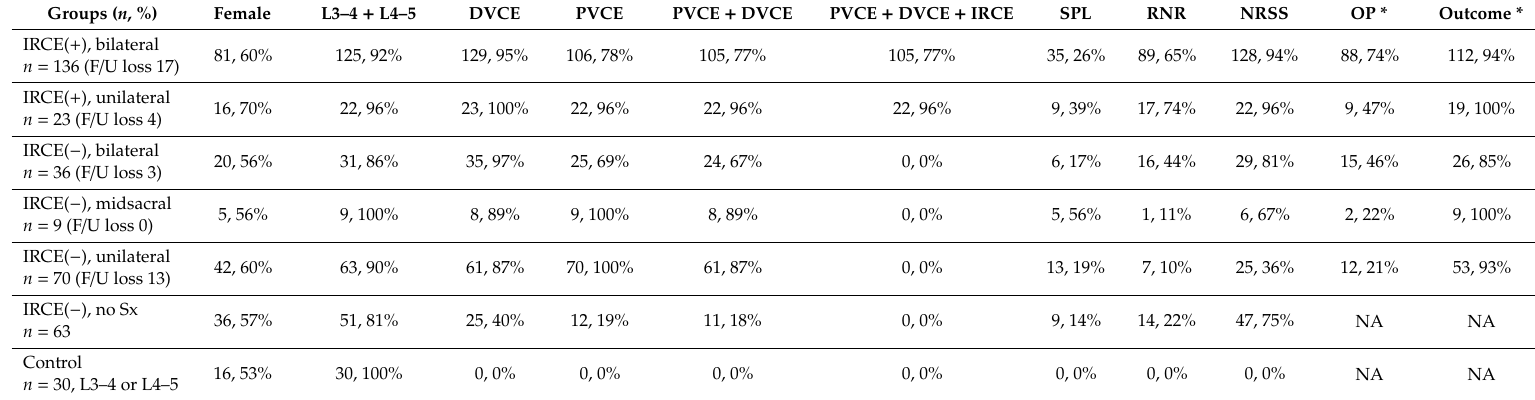
Table 2. Intergroup di ff erences of categorical